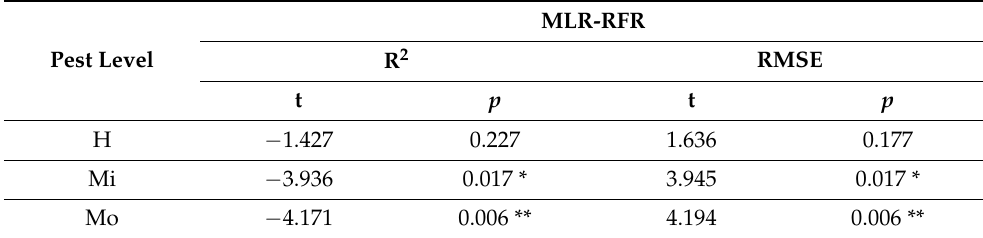
Table 5. Paired t -test of MLR and RFR